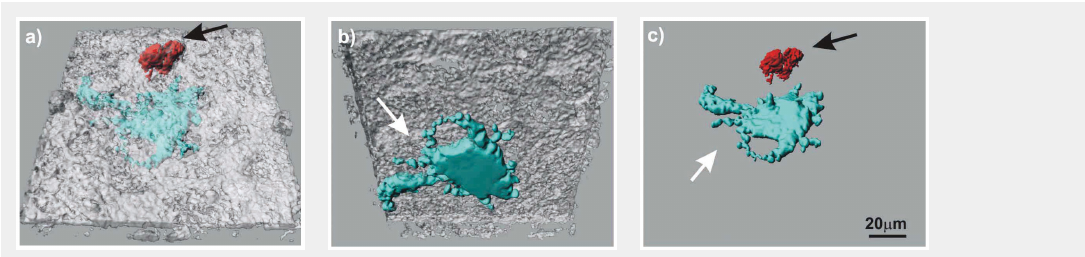
LSM images of the triple cell co-culture model. Epithelial cells (16HBE14o-), MDM and MDDC were co-cultured fixed and stained for F-actin (Phalloidin-rhodamine, white). Additionally, the MDM and MDDC were stained for specific surface markers CD14 (red), and CD86 (light blue), respectively. The cultures were observed with a Zeiss 510 Meta laser scanning microscope at a Z-interval of 0.3 µm, resulting in total 70 layers. Digital image restoration was performed using the IMARIS software from Bitplane AG. Epithelial cells (white, transparent volume rendering), MDM (red, surface rendering; black arrows), and MDDC (light blue, surface rendering; white arrows) are shown. The same data set is shown from top (A), from bottom (B), and without epithelial cells from top